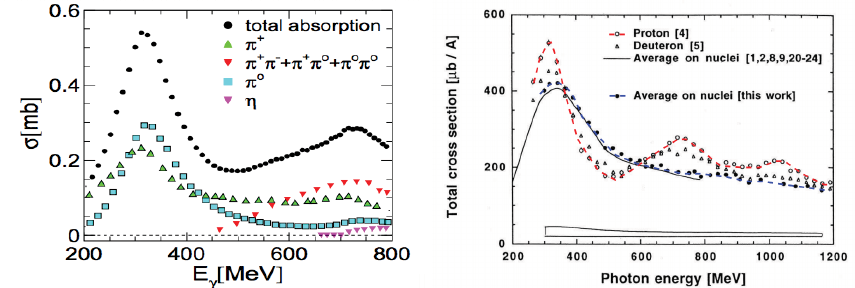
Figure 1. In the above left figure, much of the bump in the second resonance region is due to double pion production. The right figure above is also related to an old problem seen in total photoabsorption where the second resonance bump is completely suppressed for heavier nuclei.